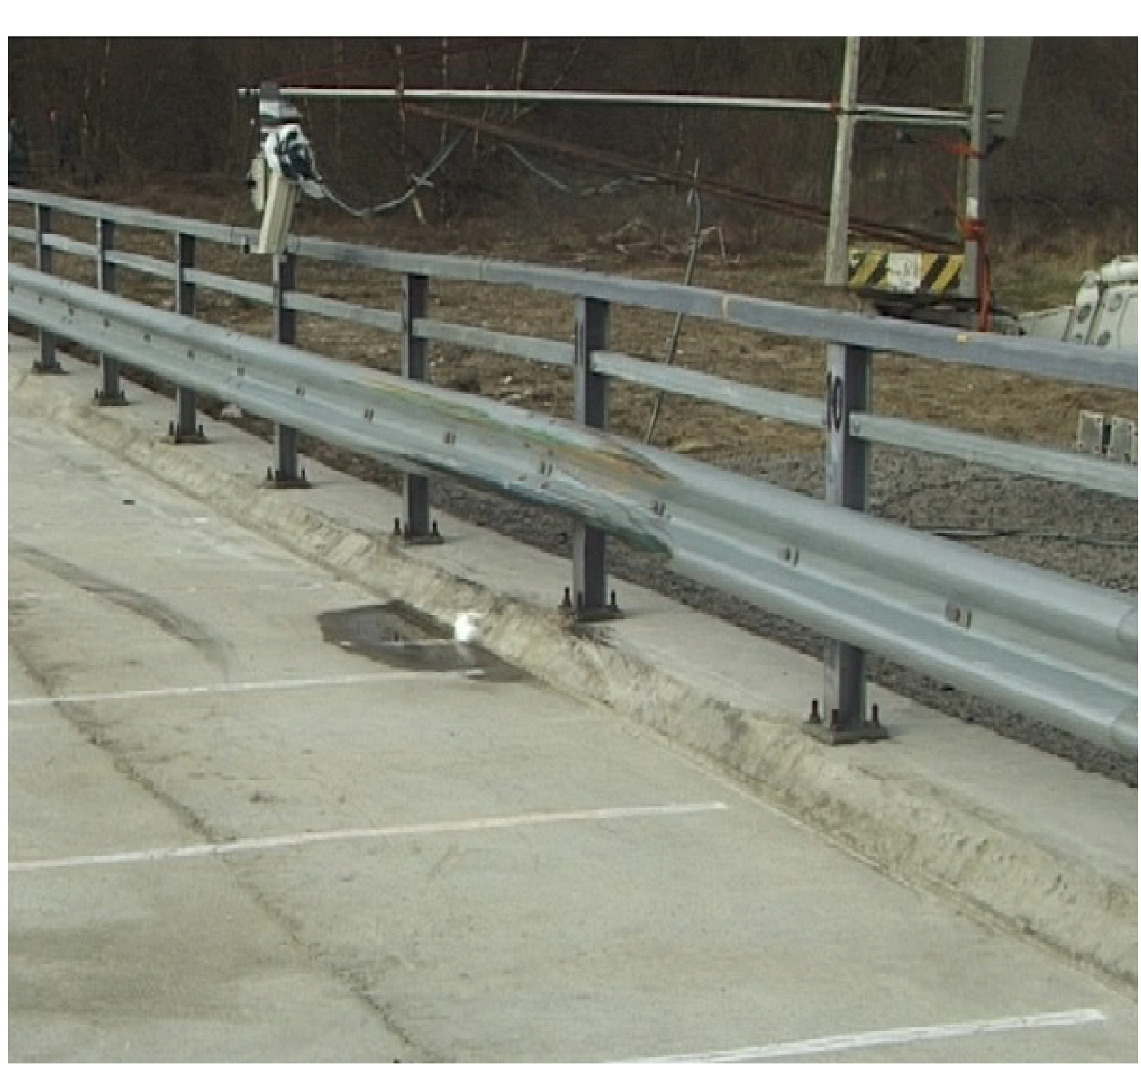
Figure 17. Safety barrier – location of